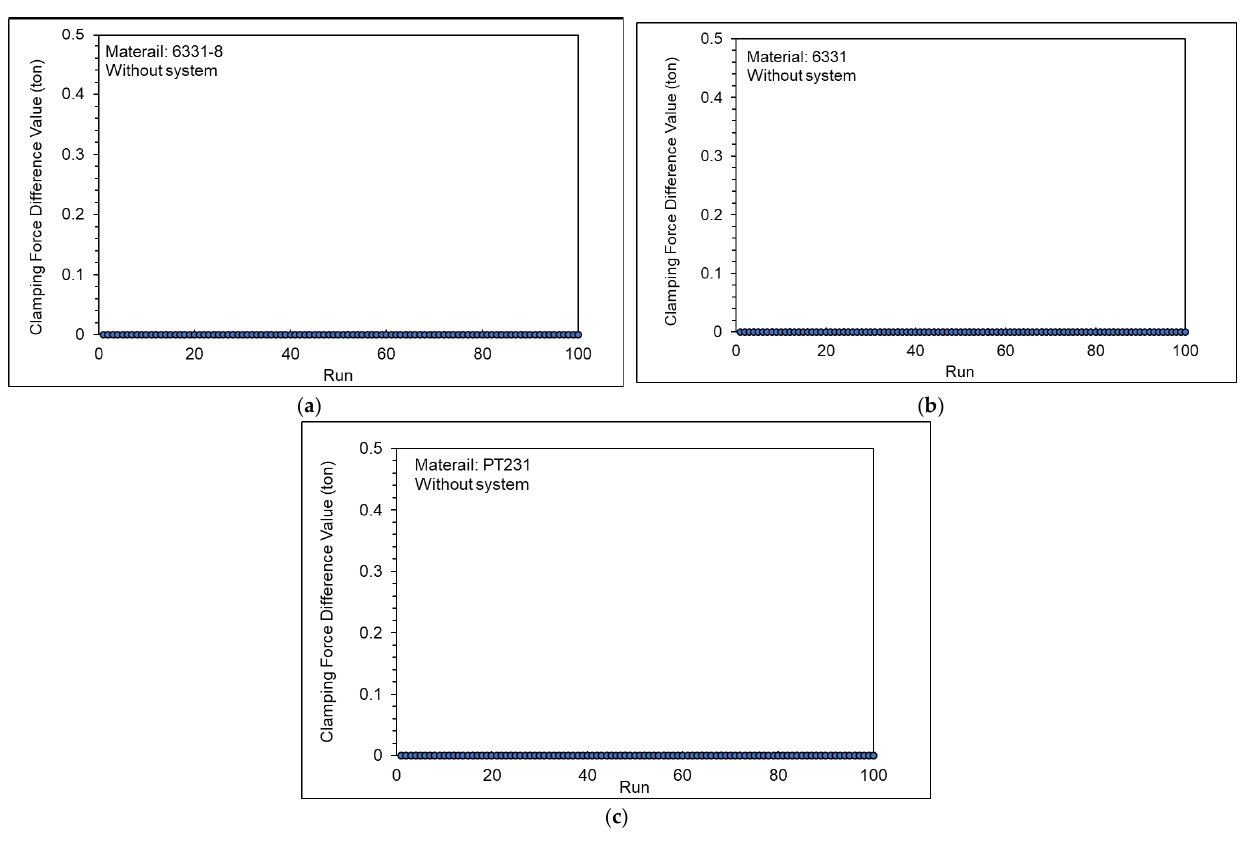
Figure 27. Clamping force difference value with adaptive process control system (( a ) 6331 − 8, ( b ) 6331, and ( c ) PT231).